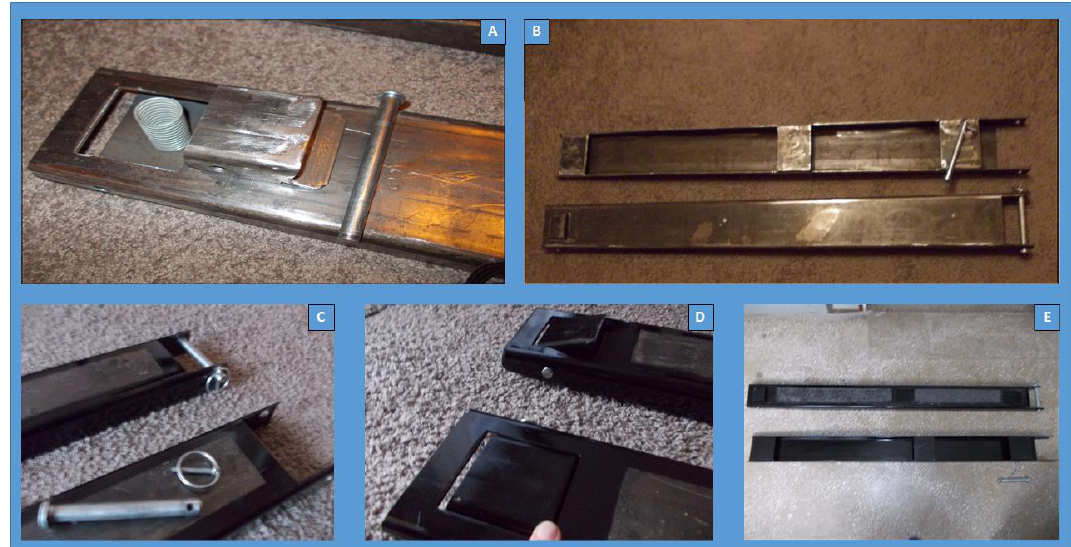
Figure 11. ( A ) — Locking mechanism; ( B ) — Fork pads in their raw state; ( C ) — Fork pads — fastening mechanism; ( D ) — Figure 11. ( A )—Locking mechanism; ( B )—Fork pads in their raw state; ( C )—Fork pads—fastening mechanism; Painted fork pads — locking mechanism; ( E ) — Ready fork pads. ( D )—Painted fork pads—locking mechanism; ( E )—Ready fork pads.